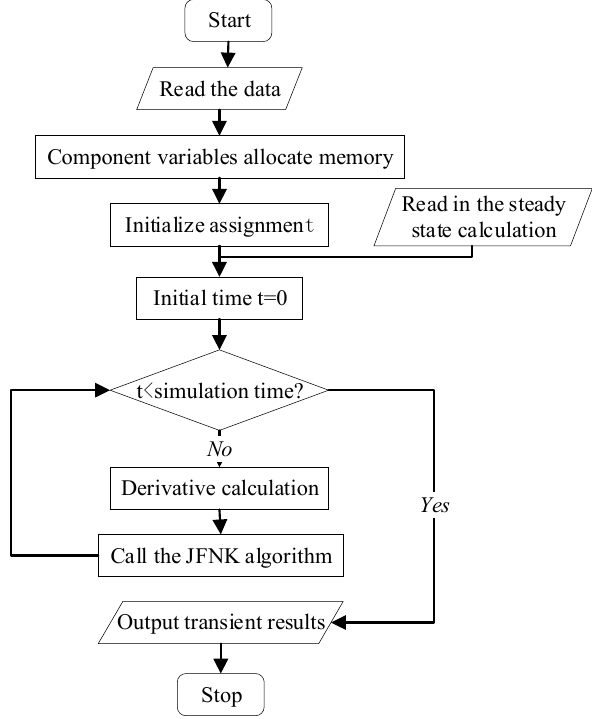
Figure 4. The TCOSS code simulation process.